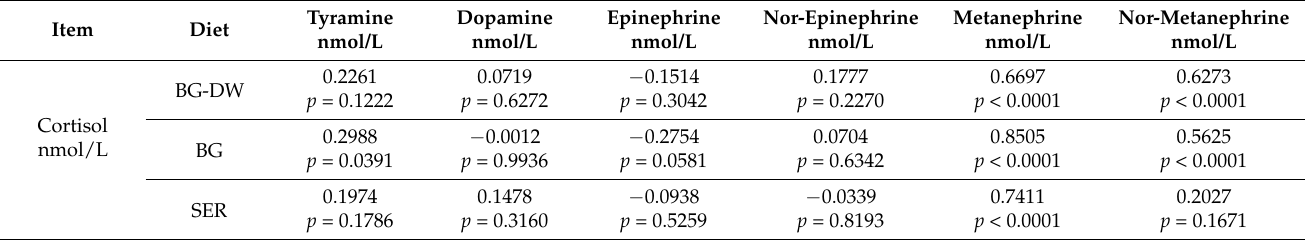
Table 2. Pearson correlation coefficients between plasma cortisol and selected biogenic amine concentrations in each diet group (BG-DW: bermudagrass hay—dewormed; BG: bermudagrass hay; SER: sericea hay).